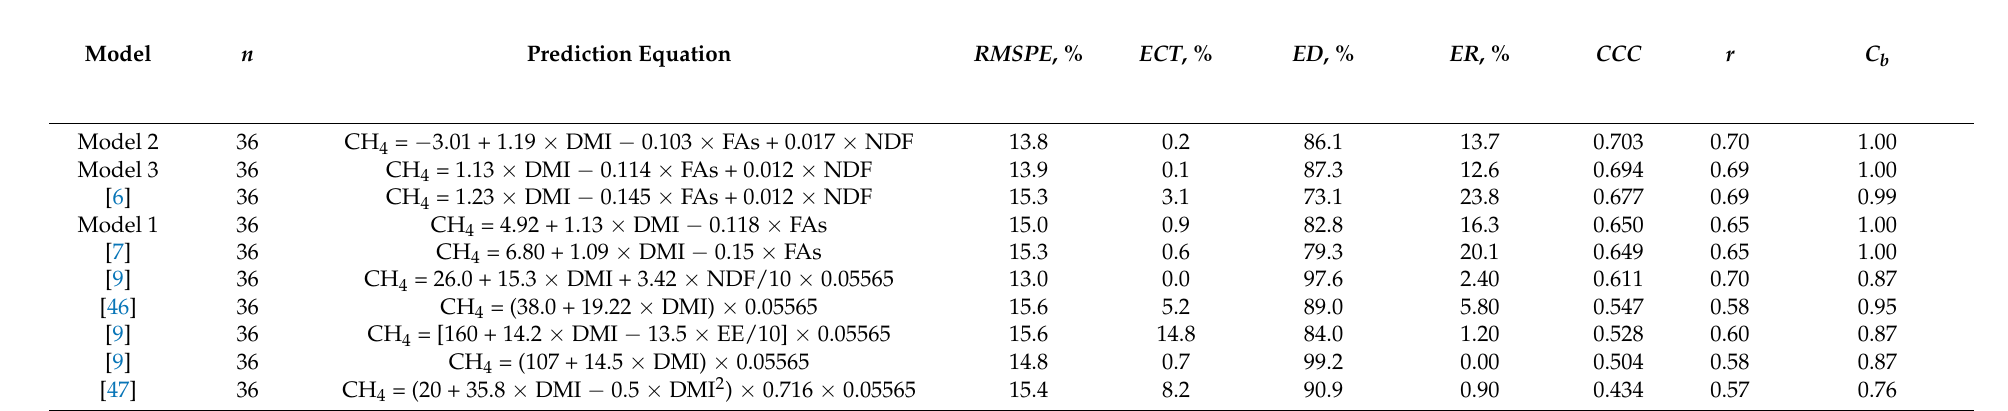
Table 4. Evaluation of developed and extant basic models ordered by decreasing CCC